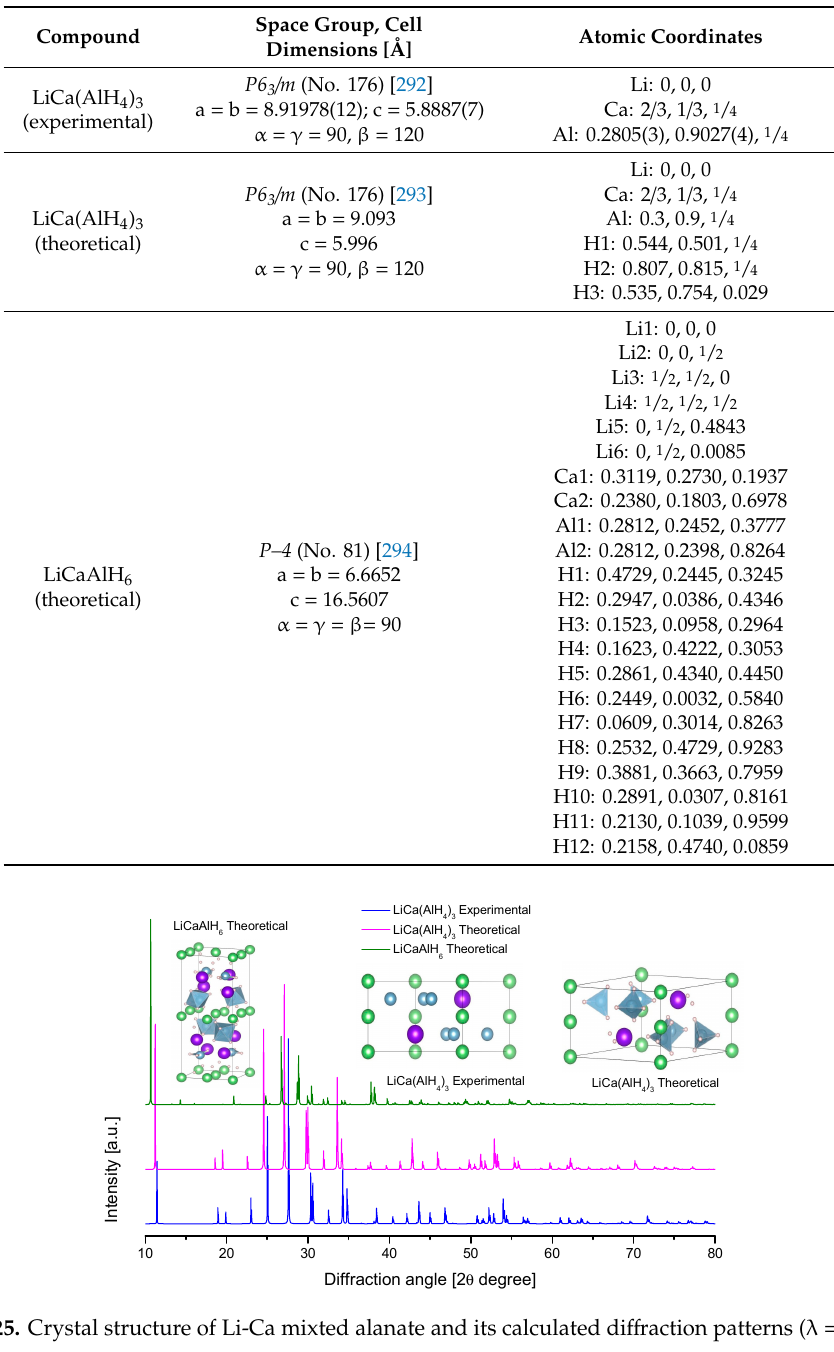
Table 17. Crystallographic data of Li-Ca mixed alanates.